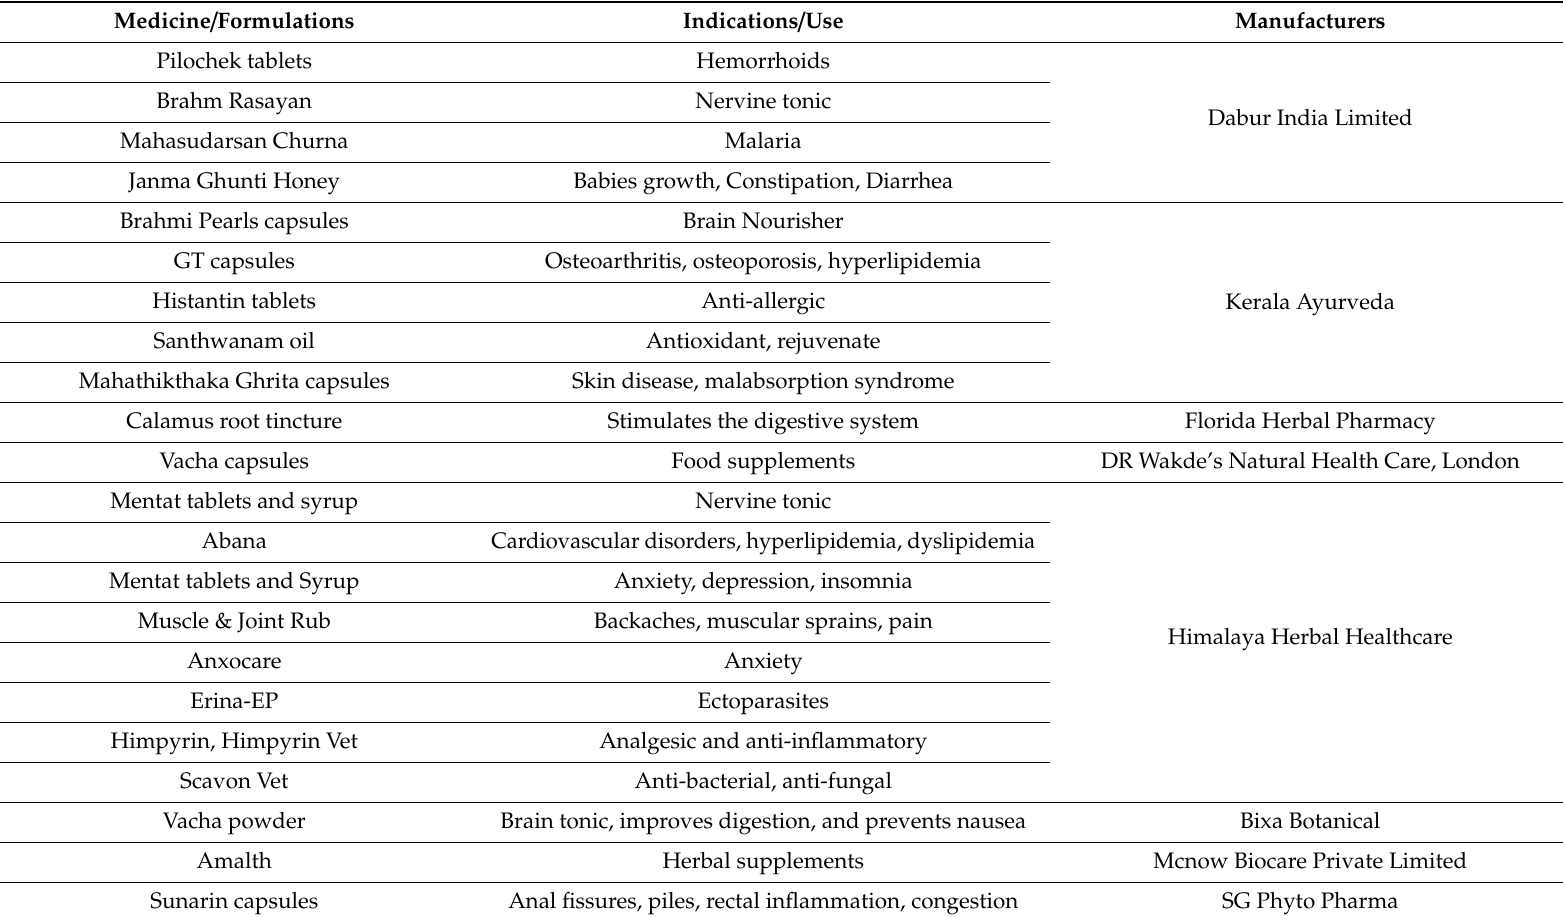
Table 2. Pharmaceutical products of A. calamus available in the